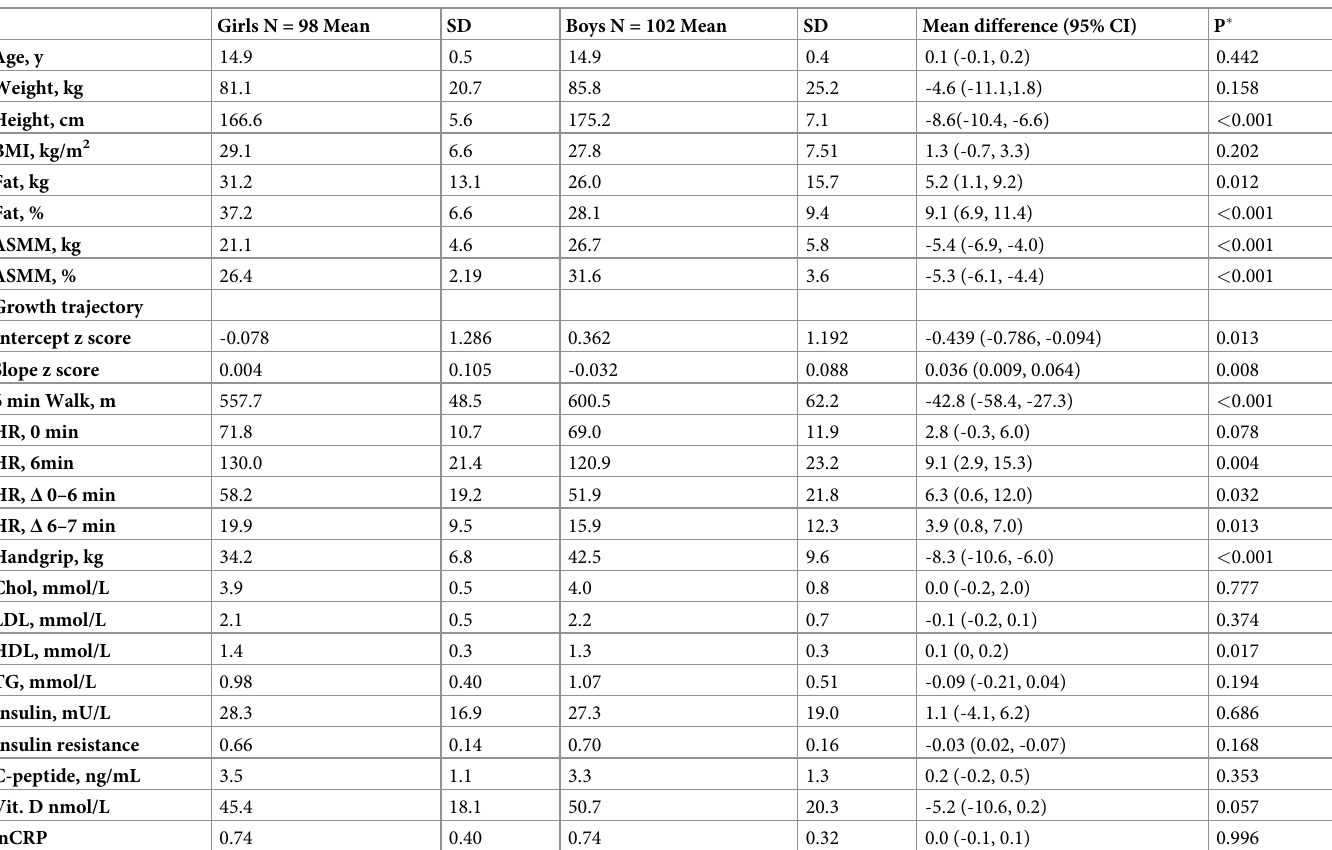
Table 1. Physical and metabolic characteristics of 200 girls and